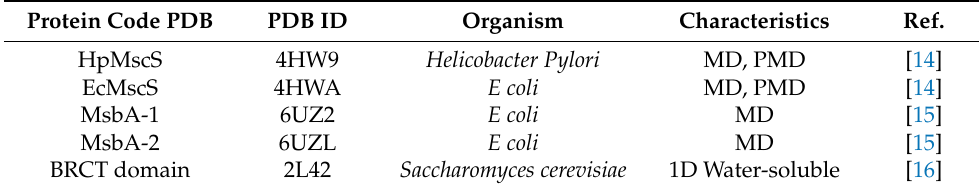
Table 1. List of proteins included in the analysis. MD: membrane domain, PMD: outside-membrane domain, 1D: single-domain